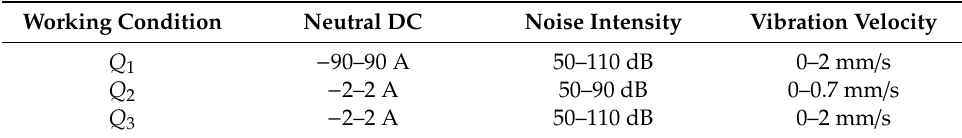
Table 2. Characteristic rules of normal